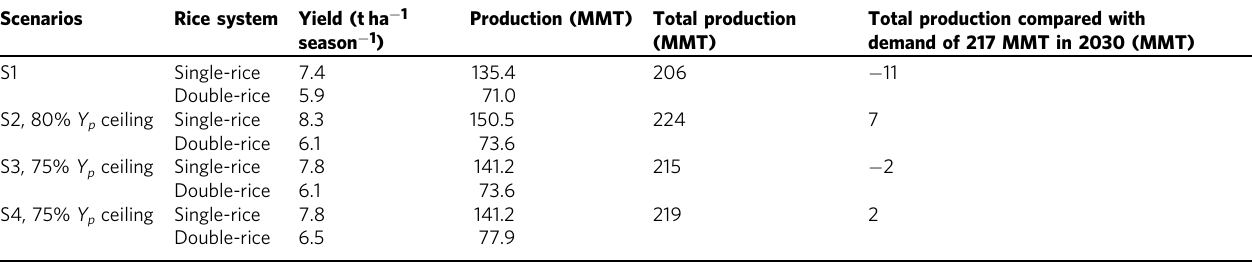
Table 1 Yields and production of single- and double-rice systems in China and total national production under four scenarios projected to 2030 Scenarios